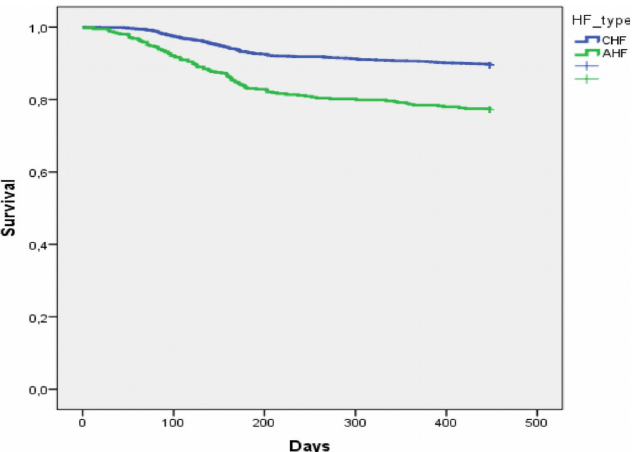
Fig 1. Kaplan–Meier curves for all-cause mortality in acute heart failure and chronic heart failure patients.